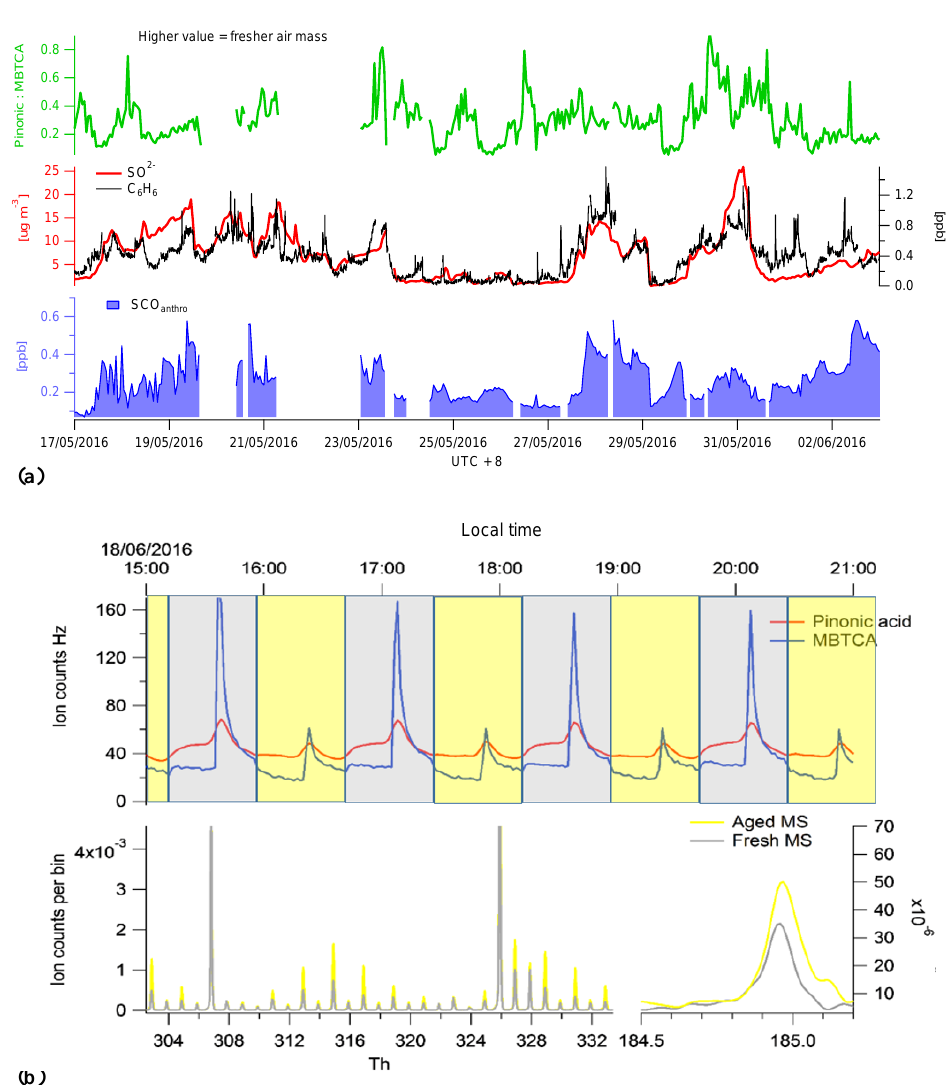
Figure 8. (a) Total benzene-/PAH-derived SCO (SCO anthro ) time series and respective SO 2 − photochemical aging (pinonic acid: MBTCA) is plotted in green. Panel (b) illustrates the mass spectral difference between fresh and aged air masses through Go:PAM and respective time series for pinonic acid and